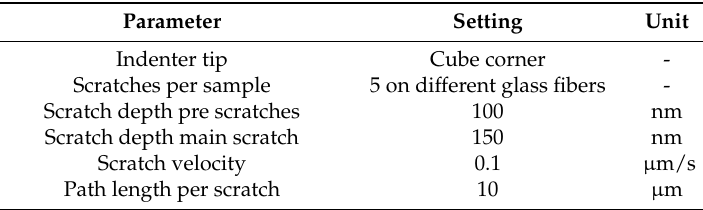
Table 10. Applied parameters of the nano-scratching